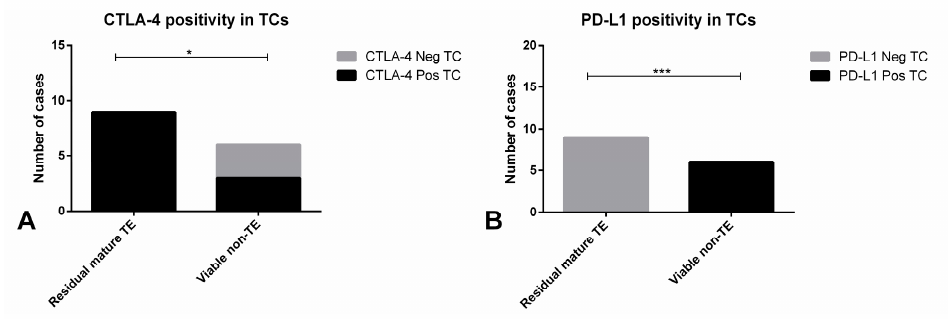
Figure 9. Immunoexpression of CTLA-4 and PD-L1 in tumor cells of metastatic testicular germ cell tumor samples. Distribution of CTLA-4 positivity ( A ) and PD-L1 positivity ( B ) in tumor cells among residual mature teratoma and non-teratoma viable disease. Abbreviations: TC—tumor cells; TE—teratoma. * refers to p < 0.05; *** refers to p < 0.001 .